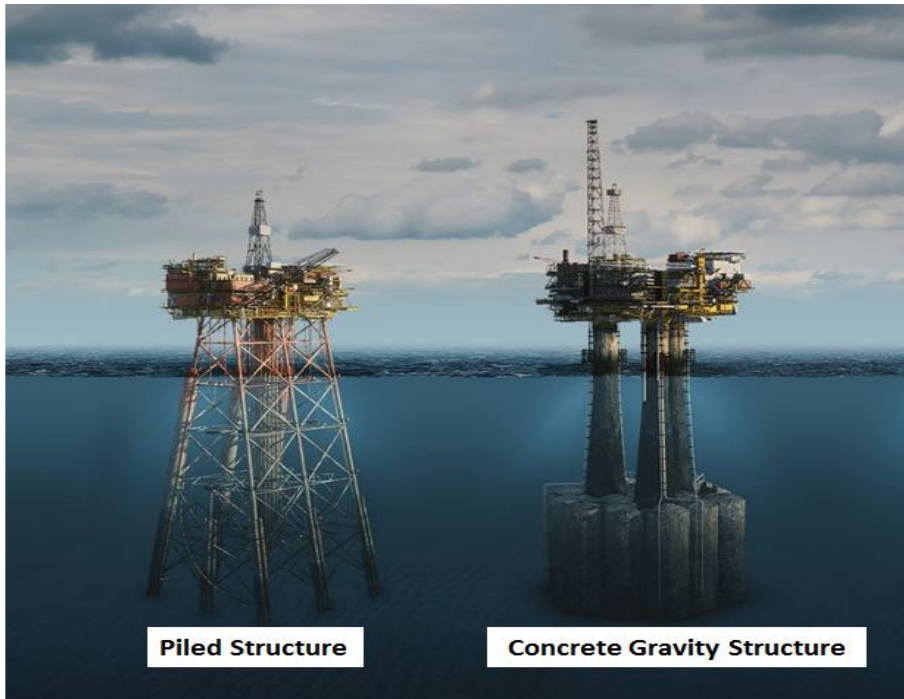
Figure 1. Piled Structure and Gravity Structure of Brent (Courtesy of Shell UK) (source: DrillingFormulas.Com [4]).